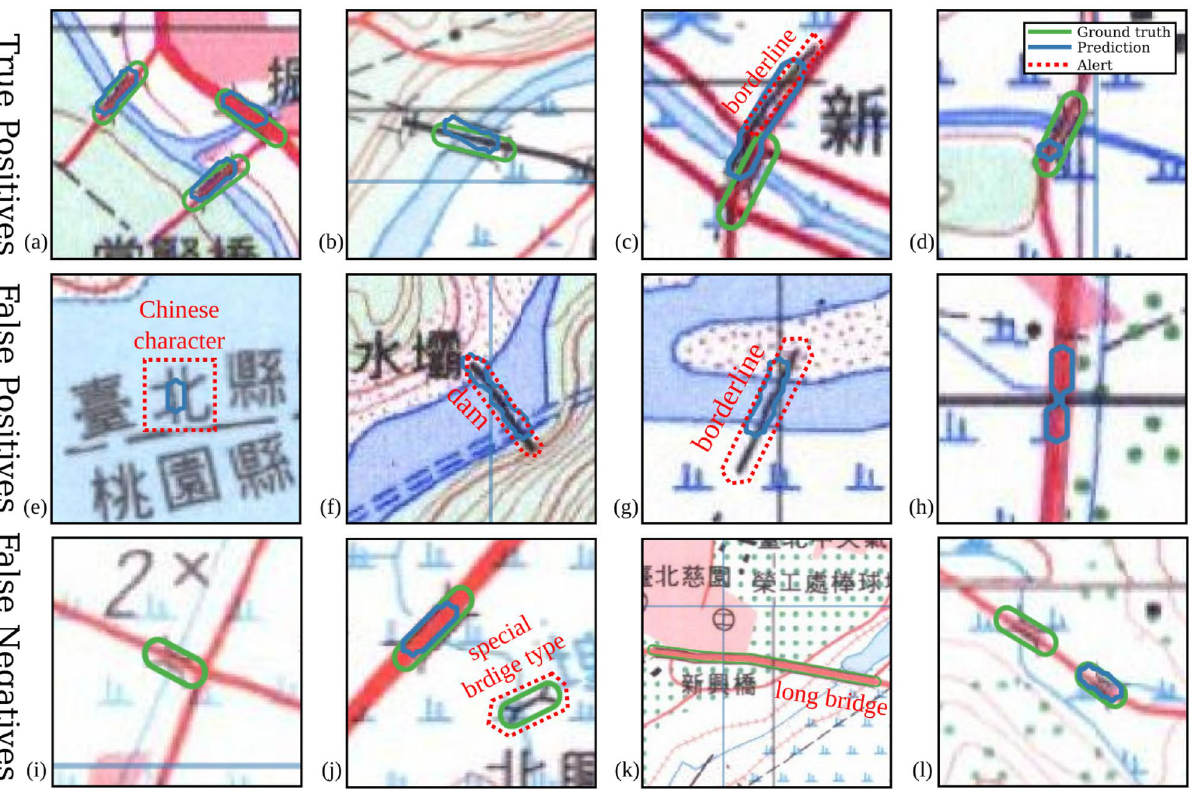
Figure 9. The examples from the results of the proposed framework. The contours in blue indicate the predicted bridges, and the ones in green represent the bridge groundtruth. ( a – d ) show the true positive examples. Although some predictions are influenced by other geographic features (such as borderlines in ( c )) and some predict only heads of bridges in ( d ), most predictions intersect bridges successfully like the ones in ( a ) and ( b ). ( e – h ) show the false positive examples. Some geographic features are easily confused with bridges, e.g. a Chinese character on a river in ( e ), the dam in ( f ), and the borderline crossing a waterbody in ( g ). For some false-positive cases, such as in ( h ), the reasons for being recognized as bridges cannot be identified. ( i – l ) show the false negative examples. Relatively small and special bridges are hard to be detected, as shown ( i ), ( j ), and ( k ). In ( l ), there are two similar bridges but only one is recognized. † The maps in this figure are provided by Taiwan Historical Maps System (https:// gis. sinica. edu. tw/ tiles erver/) with